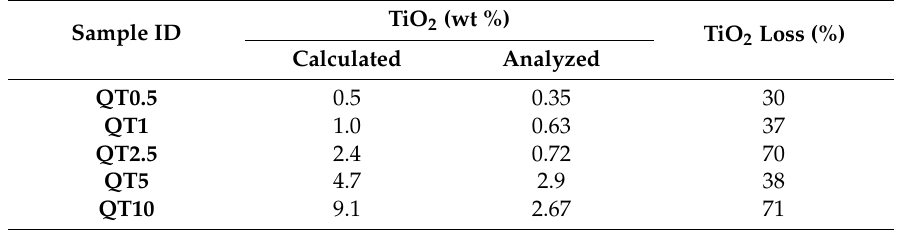
Table 1. Calculated and analyzed loaded amount of TiO 2 on quartz via silica gel binder.